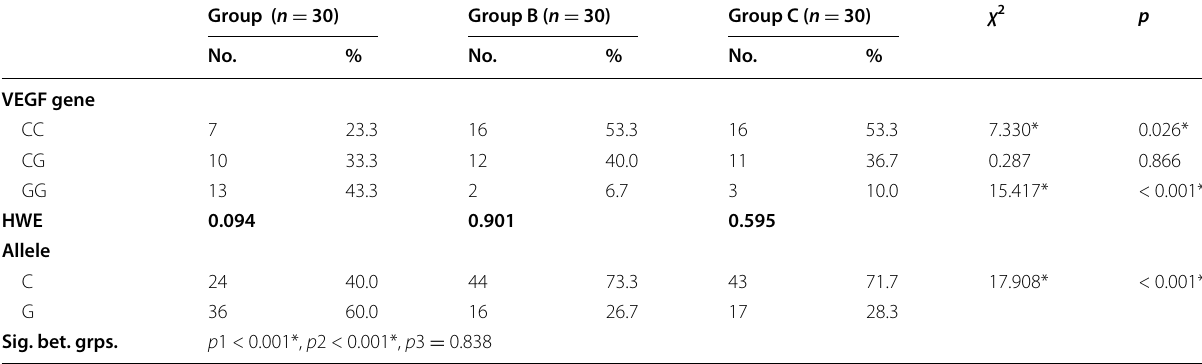
405)G (rs2010963) single nucleotide polymorphism +